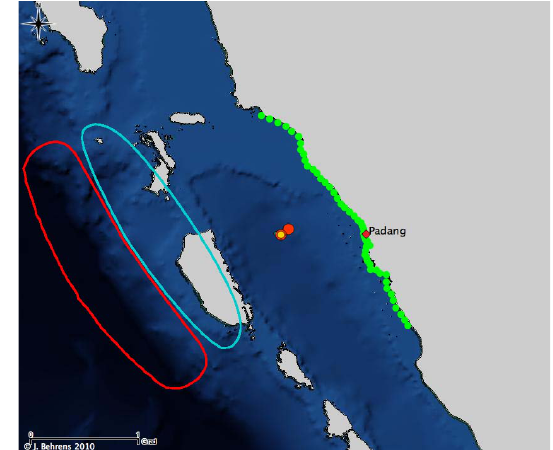
Fig. 16. Result of the selection after 5min (data set 3), analogous to Fig. 14. An insignificant GPS signal spoils the selection solution, since now a scenario with a dislocated uplift area is selected. Its M w